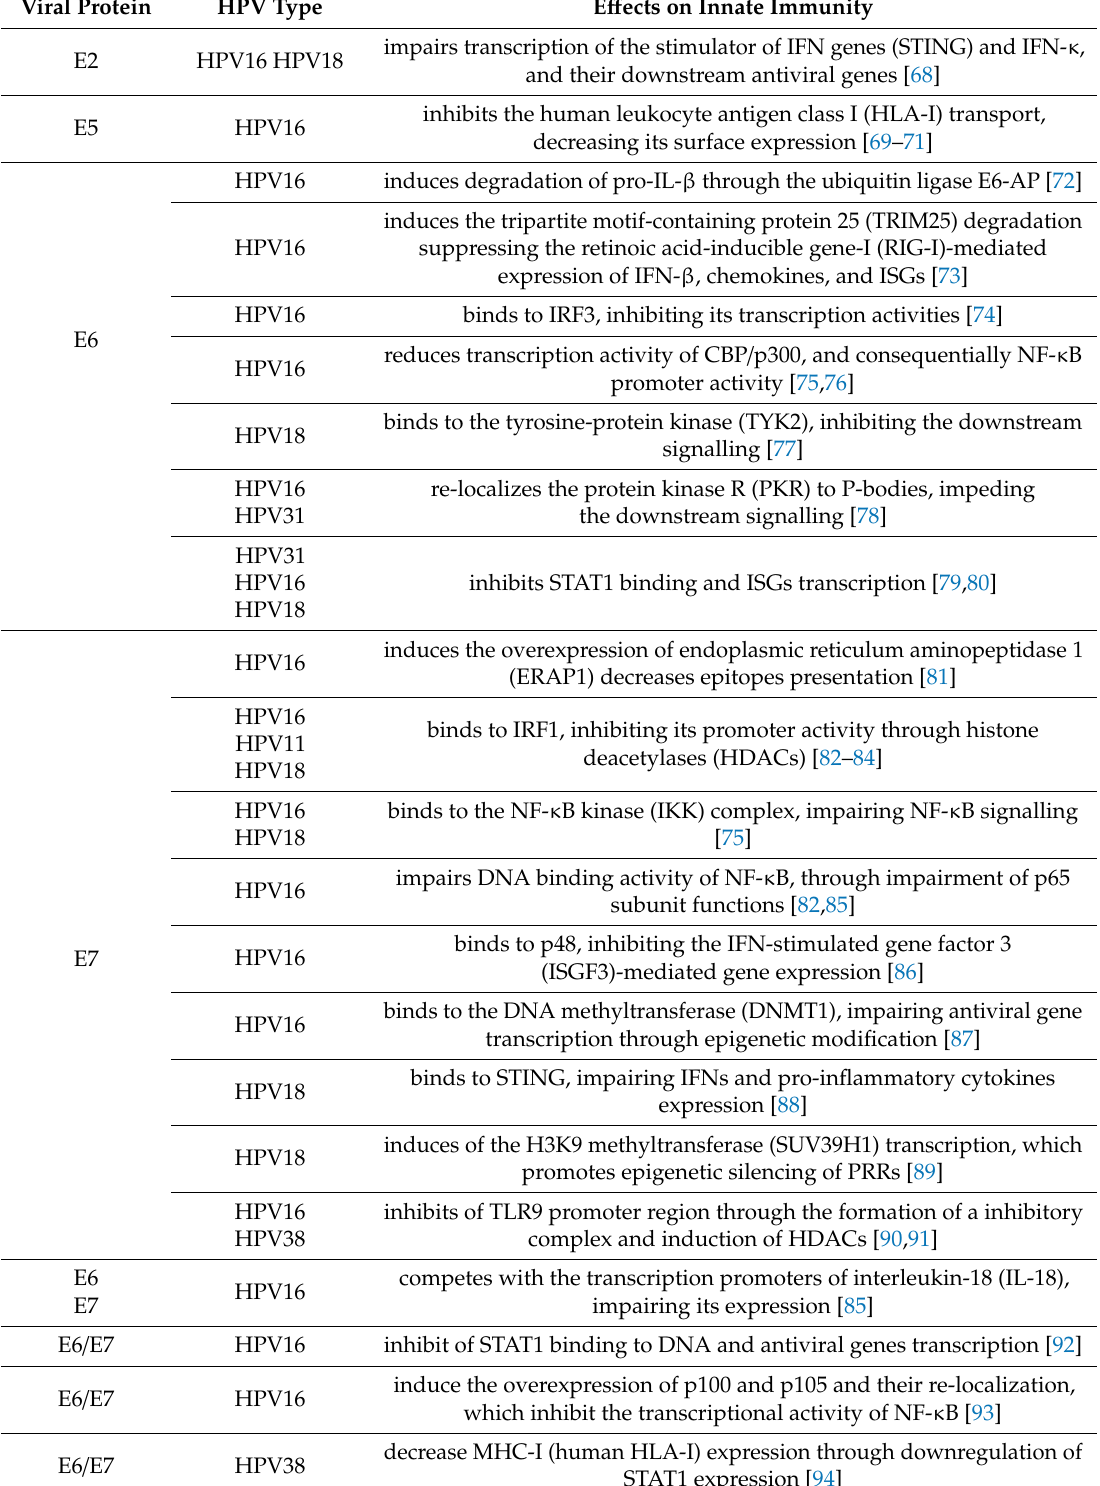
Table 2. HPV proteins’ functions on the evasion of the cellular antiviral response. Viral